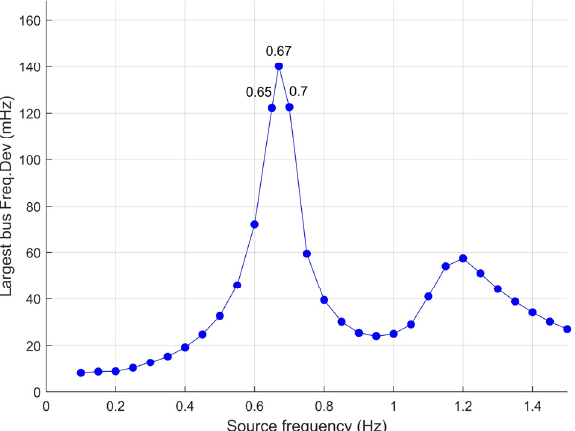
Figure 5. Frequency dimension scanning results when the forced source at Area 4 Zone 19.